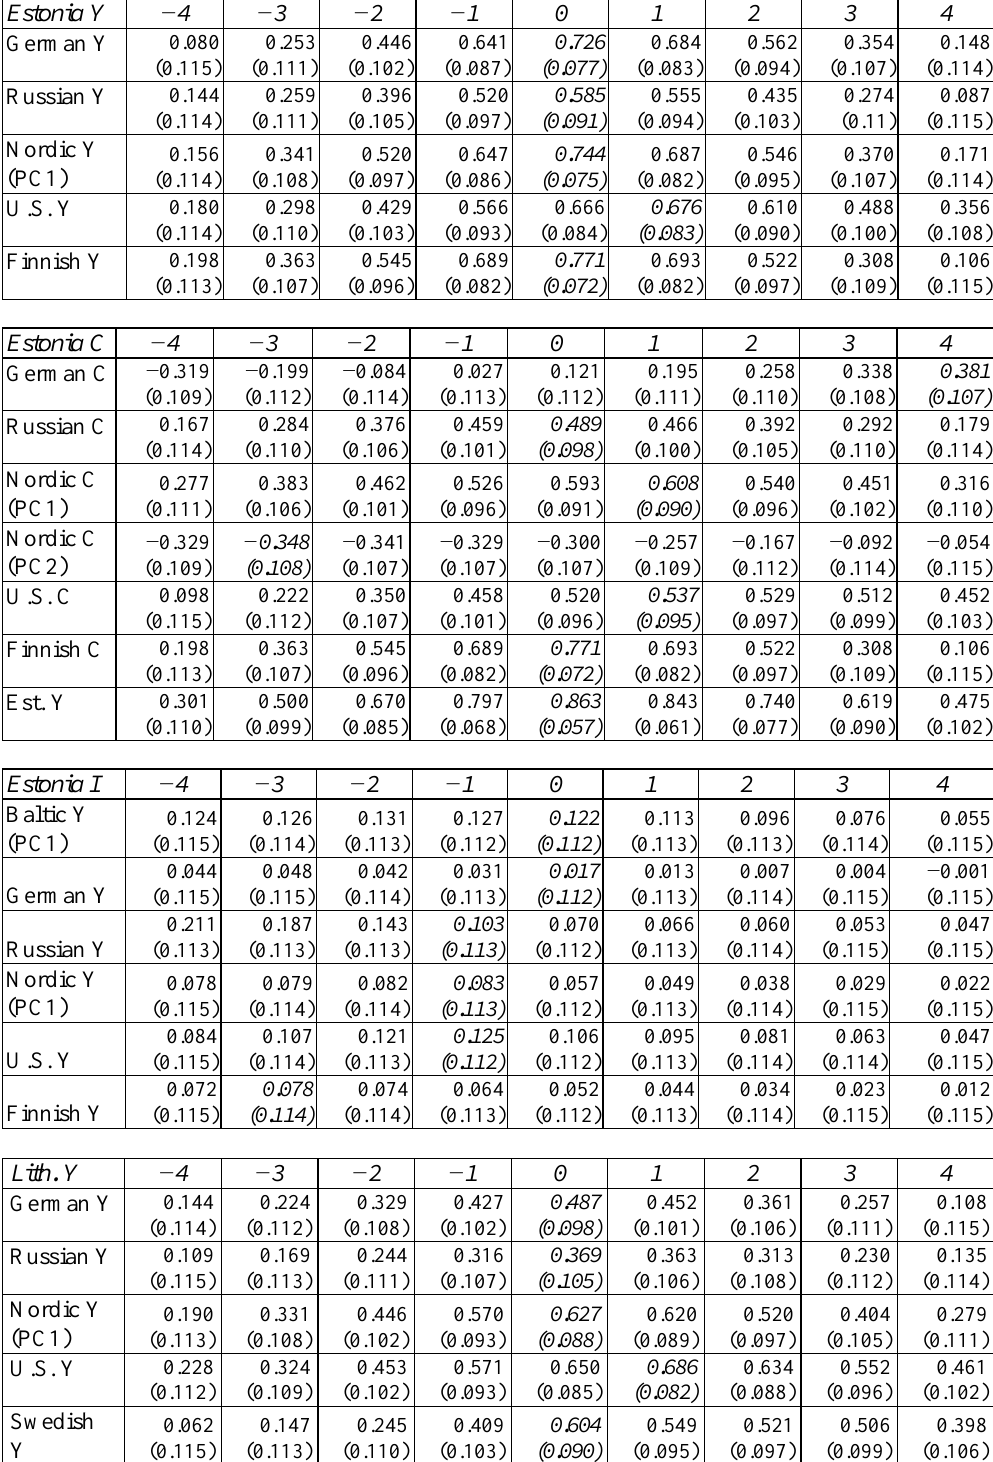
Table 2. Cross-Correlation Functions: Baltic Country Lags (− i ) or Leads (+ i ) Partner